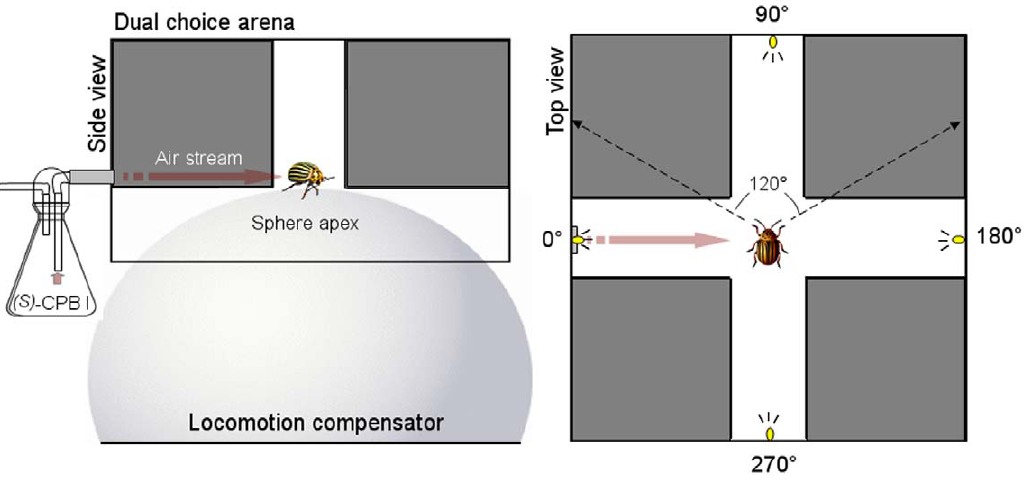
Figure 1. Dual choice arena adapted to servosphere. Schematic representation of dual choice arena adapted to the locomotion compensator where an L. decemlineata beetle walking on the apex of a sphere was stimulated with a male-produced aggregation pheromone ( S )-CPB in an air stream (side view) and opposite yellow LEDs (585 nm). The insect was able to perceive the stimuli but unable to reach any of the four arms (top view). Relative distance walked in arbitrary cones, 60 u either side of 0 u , 90 u , 180 u and 270 u directions respectively, served to quantify beetle preferences (see dashed vectors).